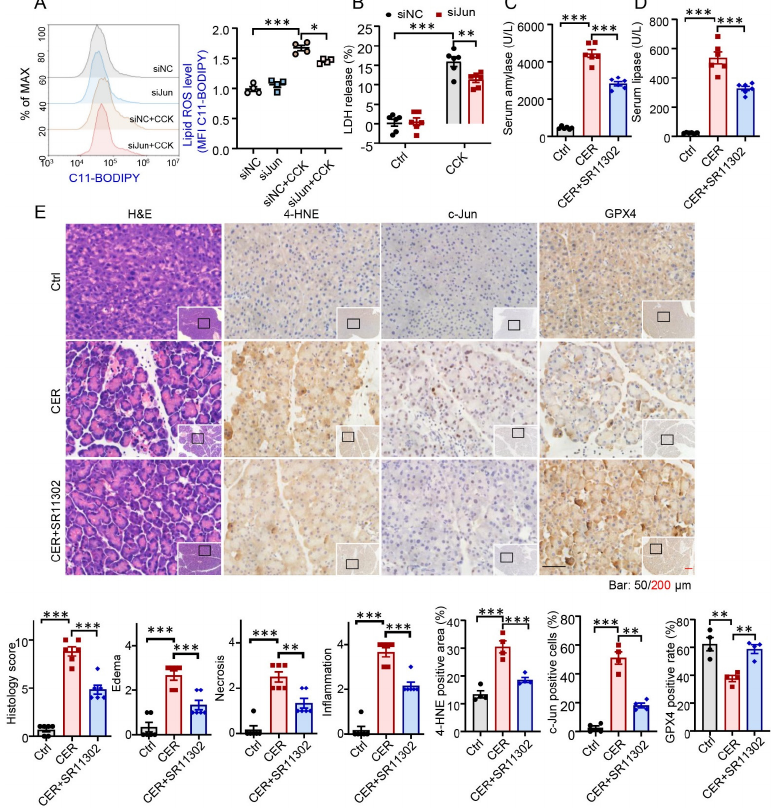
Figure 4. Inhibition of activating protein-1 (AP-1) reversed glutathione peroxidase 4 (GPX4) suppression and improved ferroptosis in acute pancreatitis. ( A , B ) After transfection with Jun siRNA for 36 h, cells were treated with cholecystokinin (CCK, 5 μ M) for 6 h, and lipid reactive oxygen species (ROS) levels and cell death were determined ( n = 4–6). ( C , D ) Serum amylase and lipase levels ( n = 6). ( E ) Representative hematoxylin and eosin (H, E) staining of pancreatic tissues of vehicle cerulein- induced mice with or without SR11302 at magnifications of 100× and 400× ( n = 6). Representative photomicrographs of pancreas stained for 4-hydroxynonenal (4-HNE), Jun, or GPX4 were assessed using immunohistochemistry (IHC) ( n = 4). * , p < 0.05; ** , p < 0.01; *** , p < 0.001; ns, not significant.